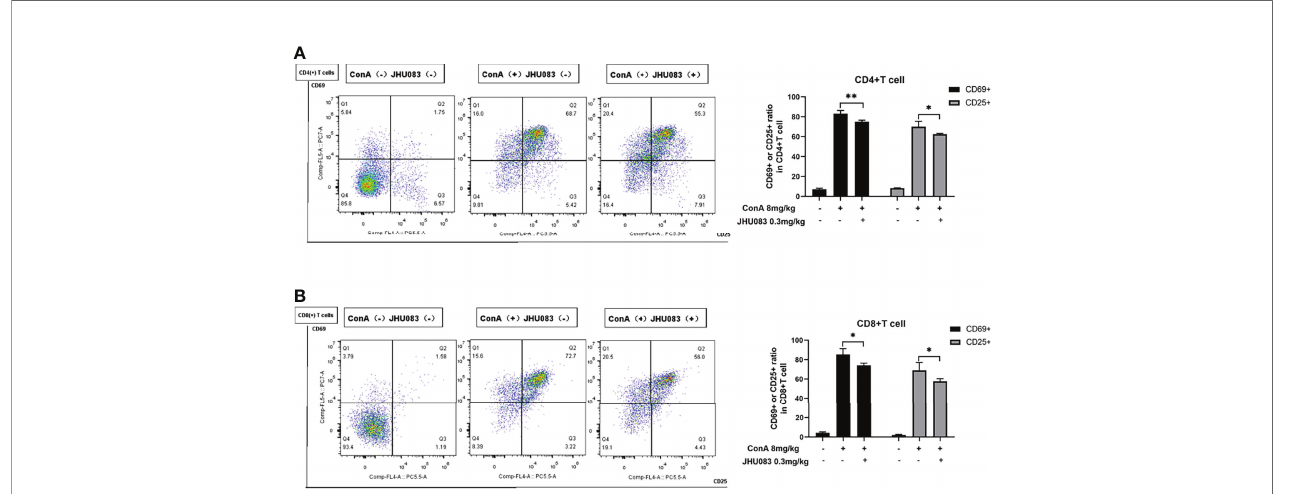
FIGURE 2 | JHU083 inhibited T cells activation in vivo . Mice of Vehicle-AIH and JHU083-AIH group were intravenously injected with 8ml/kg ConA, and Vehicle-WT group was injected with normal saline of equal volume. JHU083-AIH group was gavaged with 0.3mg/kg JHU083 24h and 1h before ConA injection, and mice of Vehicle-WT and Vehicle-AIH group were treated with equal vehicle at the same time points. (A, B) Flow cytometry was applied to analyze the expression of CD25 and CD69 of CD4(+) (A) and CD8(+) (B) T cells. Data were expressed as means ± SEM. * P < 0.05 and ** P